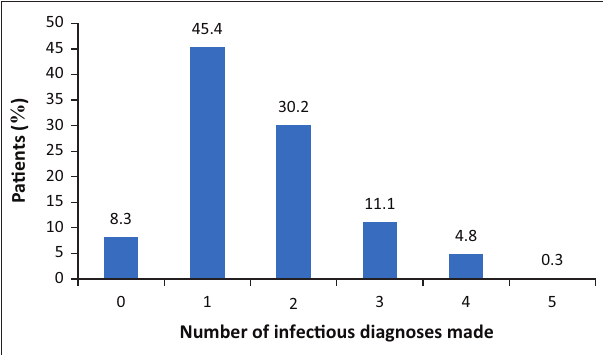
TABLE 2: Variables and their impact on patient outcome amongst patients seen by the infectious diseases department at Helen Joseph Hospital from October 2015 to March 2016.